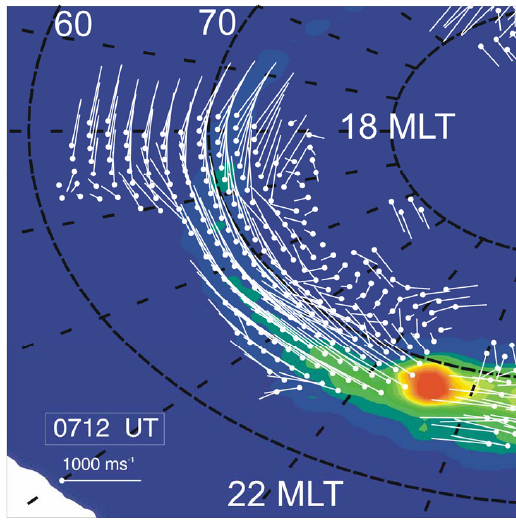
Fig. 12. The same as in Fig. 8 but for observations on 1 December Figure 12. The same as in Figure 8 but for observations on 1 December 2001 at 07:12 UT. 2001 at 07:12 UT. Fast flow equatorward of the auroral oval is seen Fast flow equatorward of the auroral oval is seen in the dusk sector (~18:00 MLT). This flow is comparable in magnitude with the one existing within the auroral oval (~65 0 ) between 18 MLT in the dusk sector ( ∼ 18:00 MLT). This flow is comparable in mag- and 22 MLT. nitude with the one existing within the auroral oval ( ∼ 65 ◦ ) between 18 MLT and 22